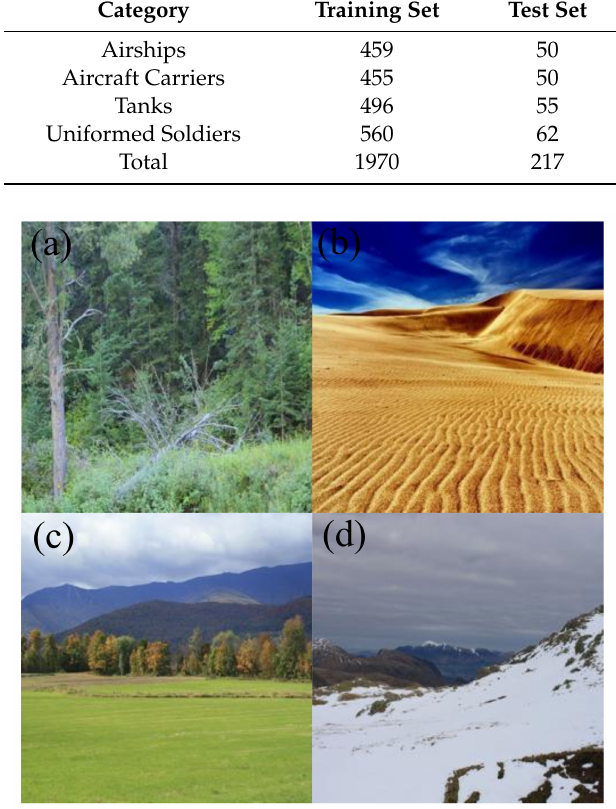
Figure 3. Data samples from the Places2 dataset. ( a ) forest; ( b ) desert; ( c ) grassland; ( d )